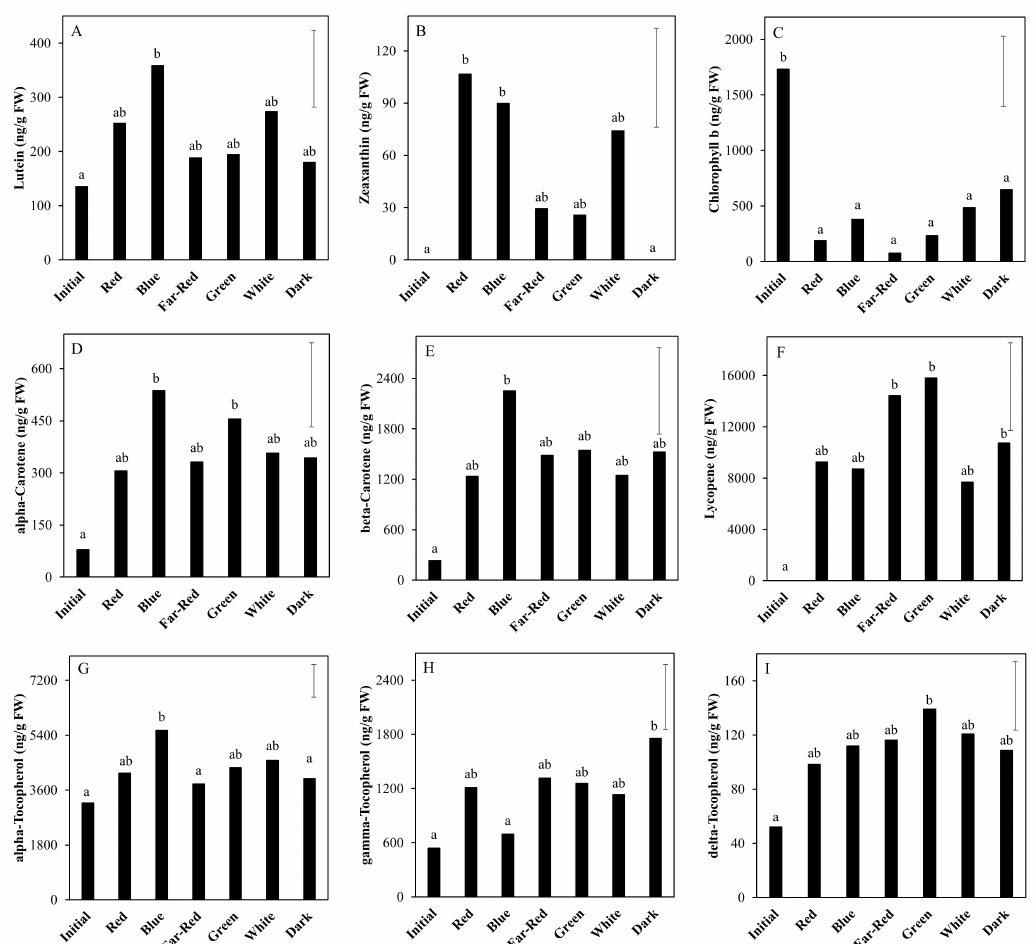
Figure 6. Levels of lipid-soluble metabolites (isoprenoids) in tomato pericarp from experiment 2, measured by LC-PDA-Fl. The fruits were exposed to white light (background) supplemented with monochromatic red, blue, far-red and green light, and to broad-spectrum white light (white) or no light at all (dark) for seven days. Initial values represent fruits at start of experiment. Error bars indicate the least significant di ff erence; letters ( A – I ) indicate significant di ff erences between light treatments at α = 0.01, n = 3 (three pools of two fruits each).